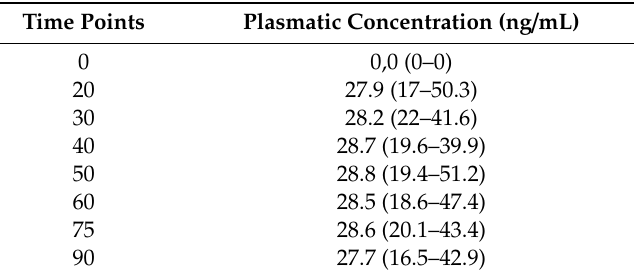
Table 3. Plasmatic